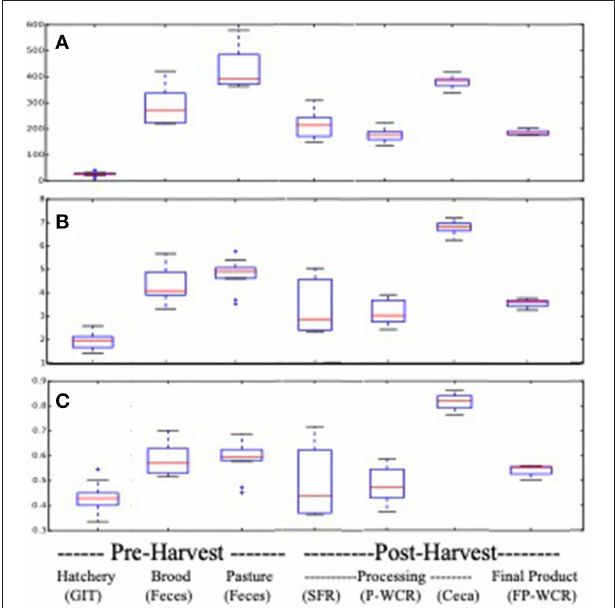
FIGURE 1 | Alpha-diversity boxplots for microbiomes from different sample types and stages along the farm-to-fork continuum of a pasture-raised broiler flock. (A) Comparison of richness based on the chao1 metric. (B) Comparison of diversity based on the Shannon Diversity metric. (C) Comparison of evenness based on the equitability